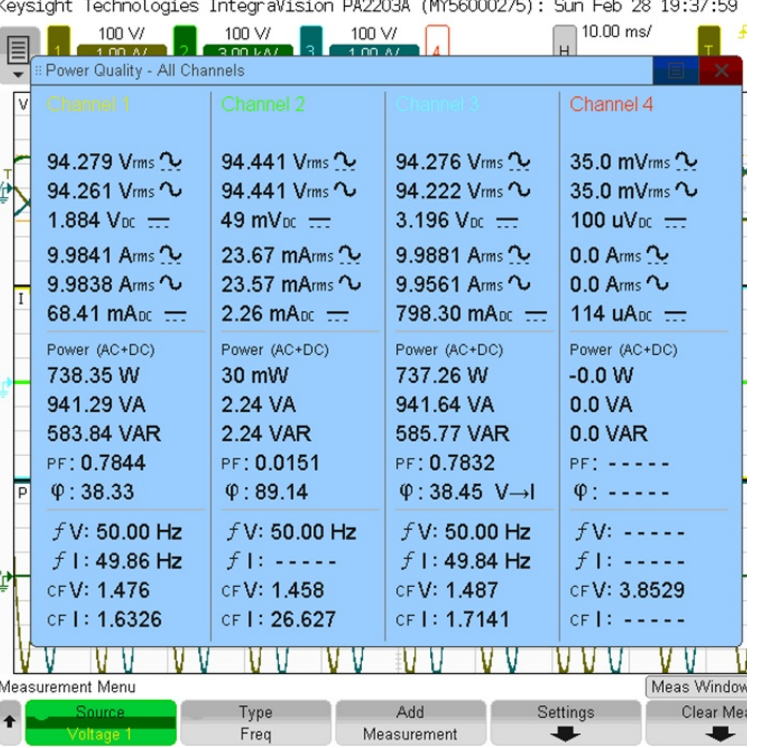
Figure 13. Voltage sag conditions in grid connected to induction motor under loaded conditions.